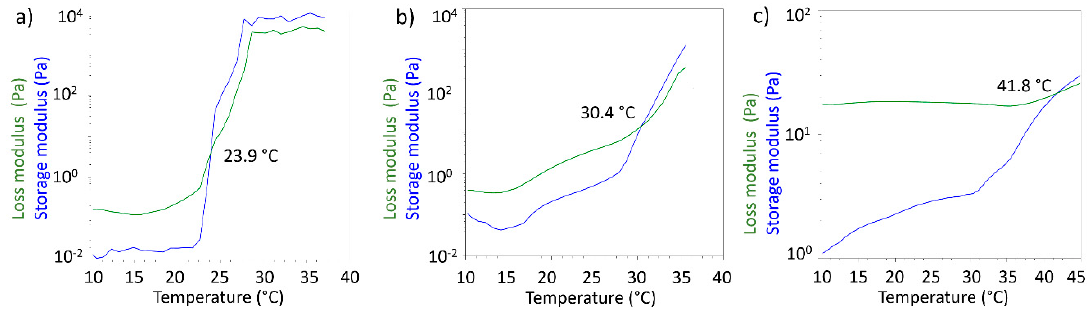
Figure 9. Storage modulus (G’) and loss modulus (G’’) as a function of temperature of: ( a ) 20% w/v PF127 aqueous solution; ( b ) S-TNH; ( c ) M-TNH.